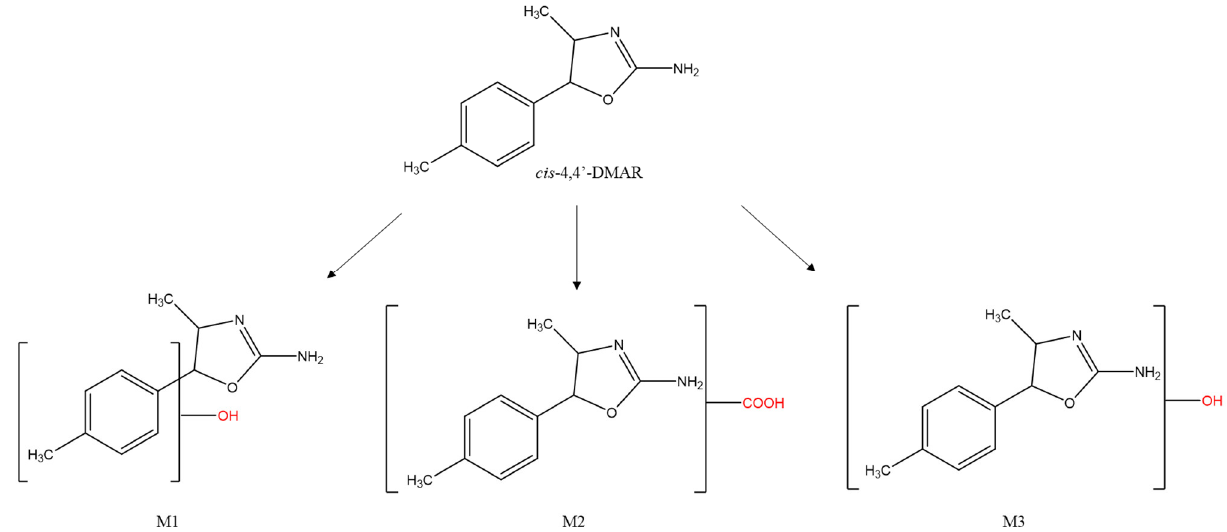
Figure 6. Structures of cis -4,4’-DMAR and its principal markers: hydroxylated (M1, M3) and carboxylated (M2). In the present study, the excretion levels of M1, M2 and M3 were compared in the two groups of mice. The first group was administered with (±) cis isomer and the second group was co-administered with both isomers at the same dose (10 mg/kg). The aim was to evaluate changes in the excretion profile of these metabolites (M1–M3) between the two groups. The excretion levels of the individual metabolites were compared as a percentage ratio. This ratio was calculated considering the excretion of the parent compound, assuming the percentage of (±) cis -4,4′-DMAR as 100%. The data were graphically reported as box plots, with the calculated minimum, maximum, median and average values (Figure 7A).